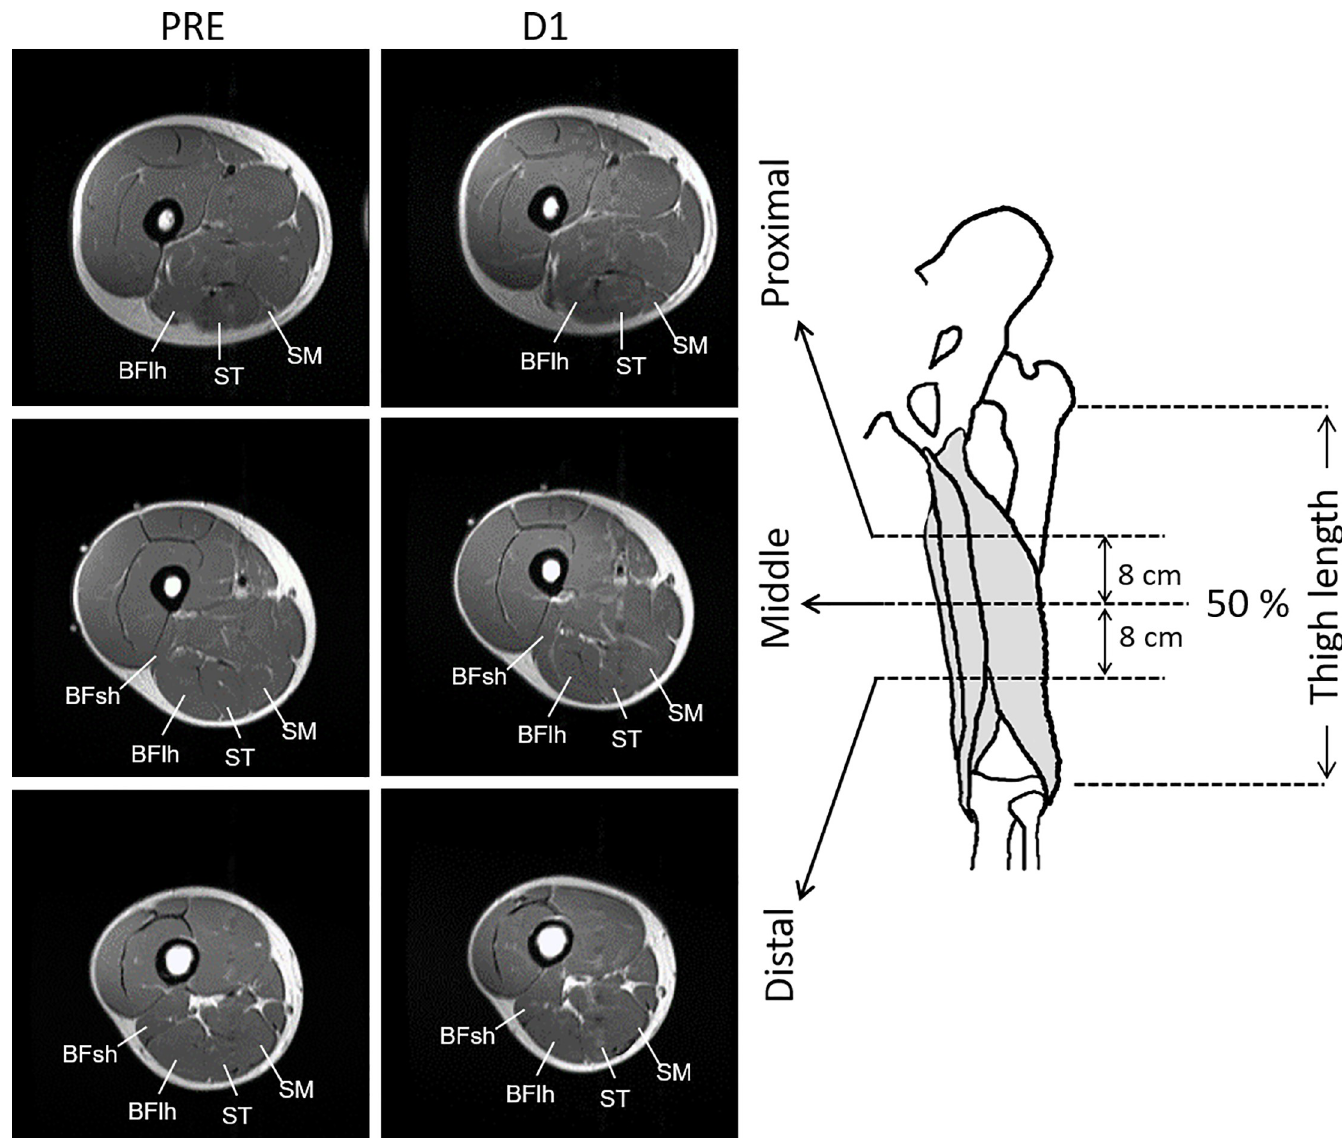
Fig 1. MRI measurement sites. Examples of T 2 -MRI at the proximal, middle, and distal sites scanned before (PRE) and at 1 day (D1) after a full marathon race. BFlh, biceps femoris long head; BFsh, biceps femoris short head; MRI, magnetic resonance imaging; SM, semimembranosus; ST, semitendinosus.